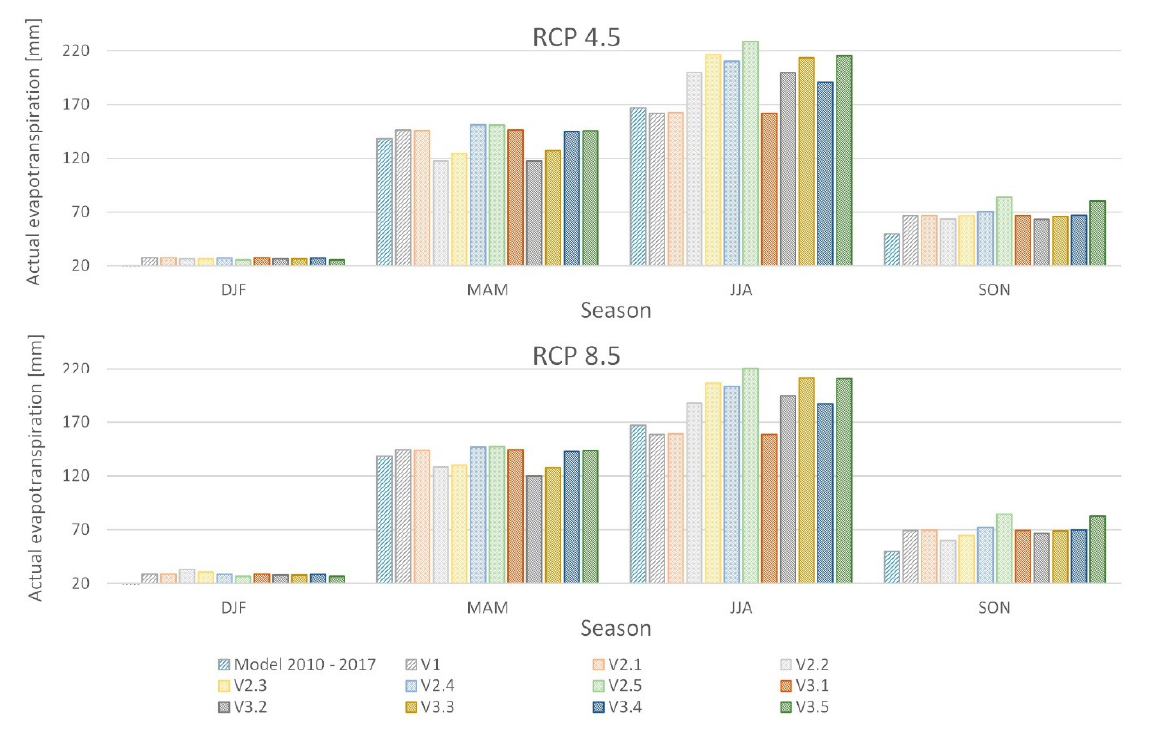
Figure 6. Comparison of the average distribution of actual evapotranspiration by season for the SWAT 2010–2017 simulation period with variants 1–3 for the RCP 4.5 and RCP 8.5 climate change scenarios, for the years 2041–2050 in the Bystra catchment (author’s own study).